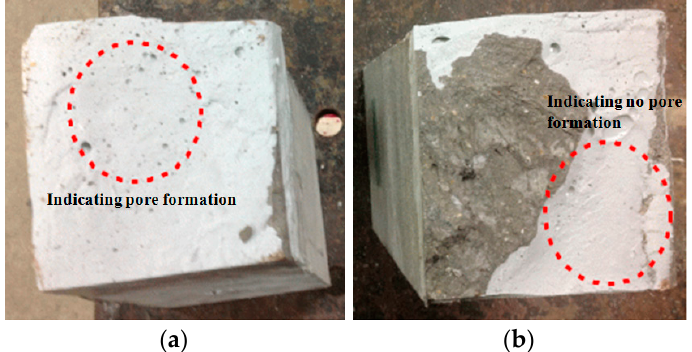
Figure 19. Interfacial fracture section and pore reduction (10 mm thickness); ( a ) non-MS; and ( b ) MSAE.